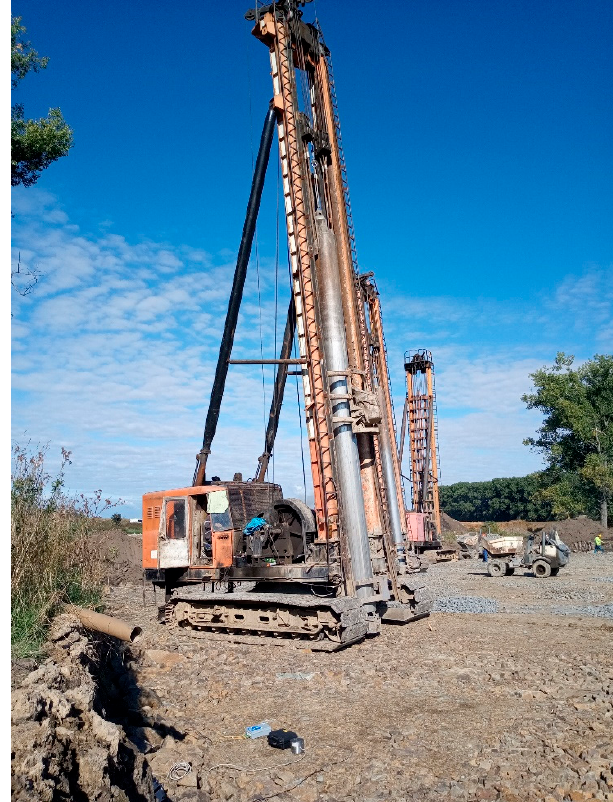
Figure 4. Measurement site (red site A)—on the left optical sensor under development, in the middle BRS32.